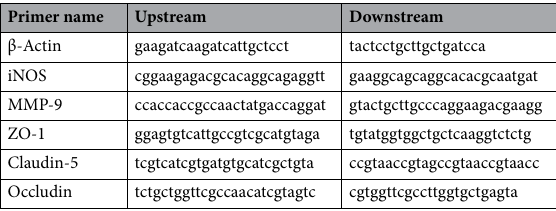
Table 1. The primers and base sequences used in this